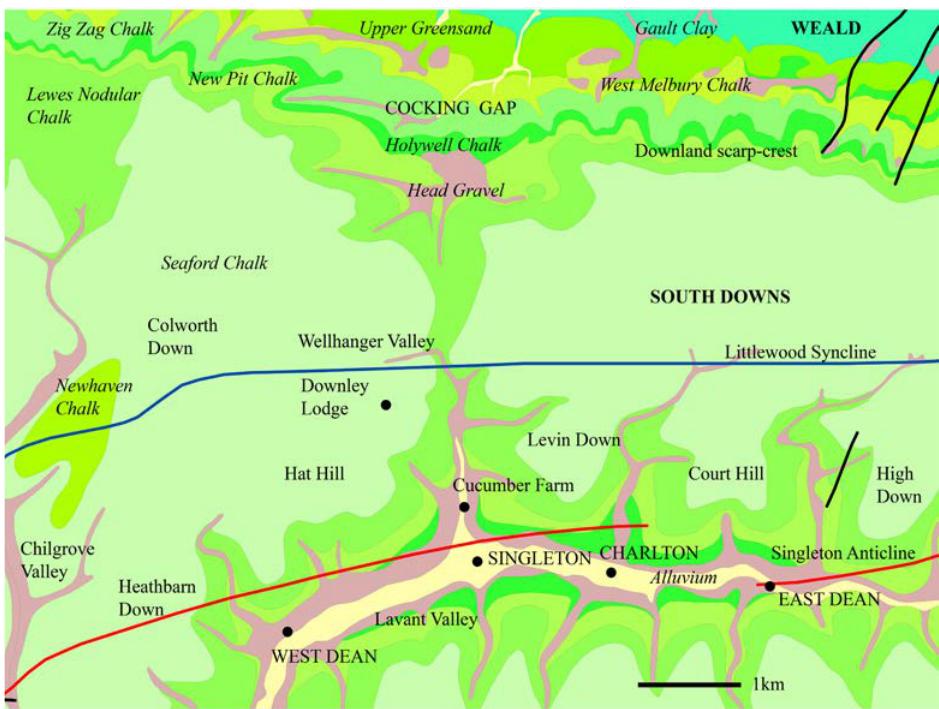
Fig. 3: Geology and location map for the Downley area. The lodge site is located on the Downs between Hat Hill and the Wellhanger Valley. (Contains Ordnance Survey data © Crown copyright and database right